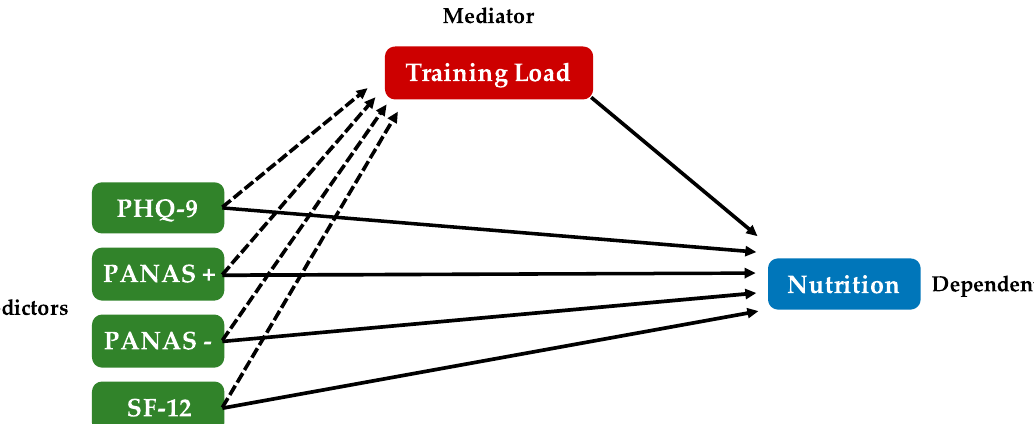
Figure 5. The theoretical model of the mediating effect of training load on the relationship between psychological states and nutritional choices. Solid lines represent a direct effect (predictors on dependent, mediator on dependent), while dashed lines represent the mediation effect.